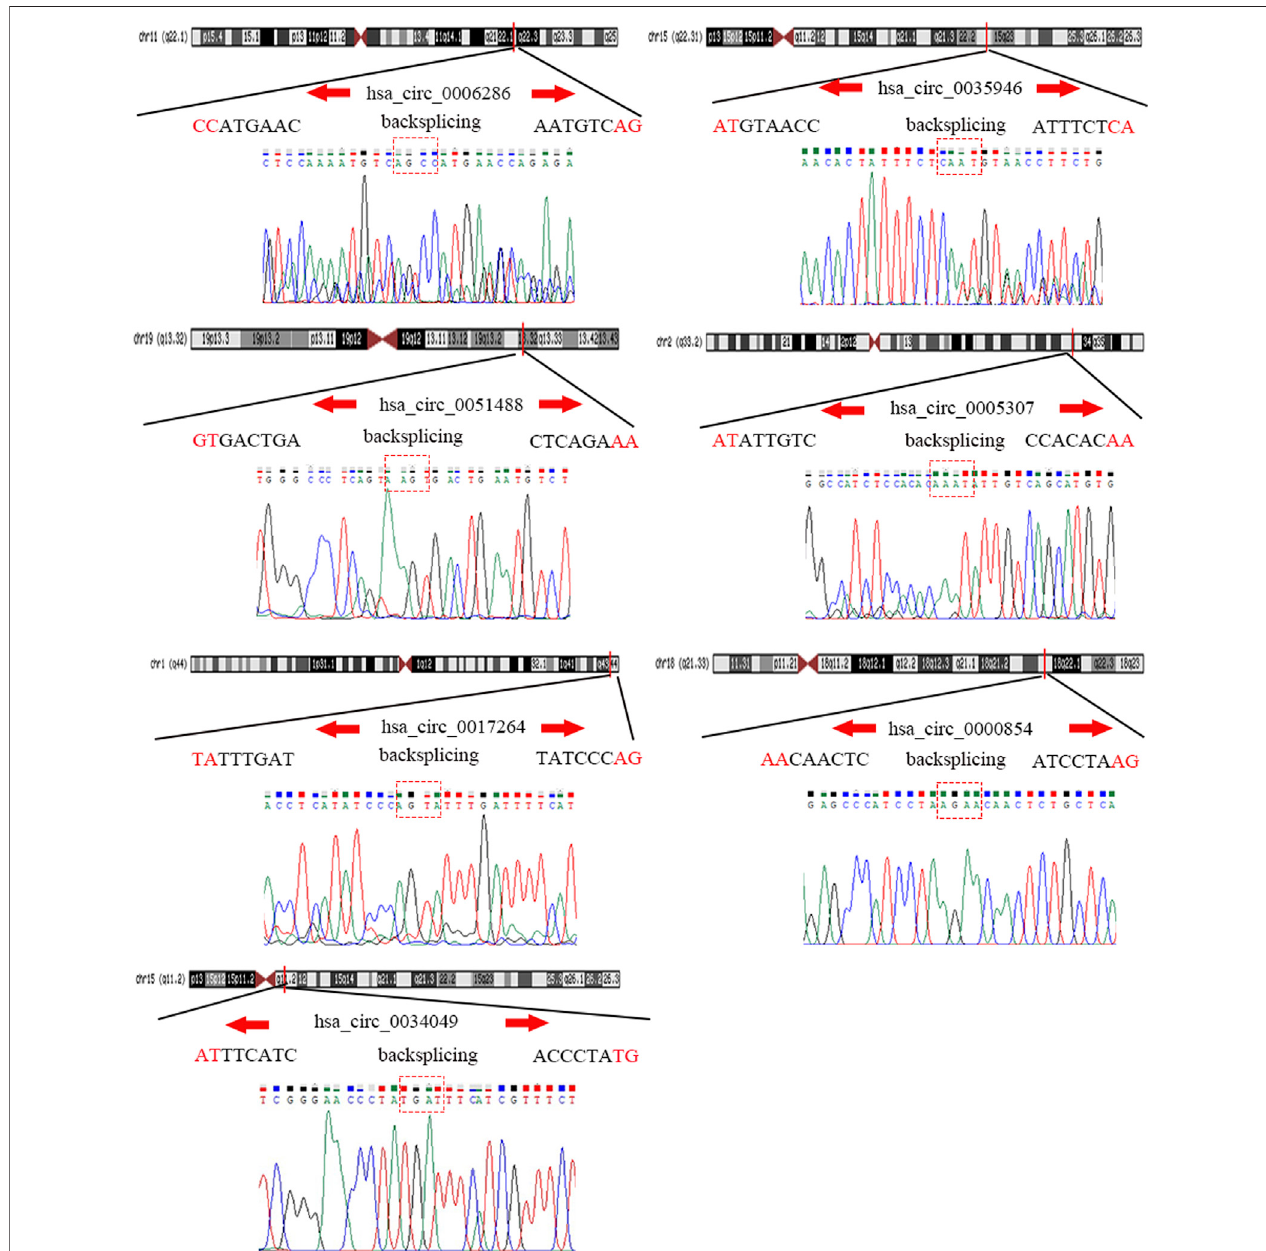
FIGURE 4 | Sanger sequencing veri fi ed the speci fi city of the primers of candidate circRNAs.